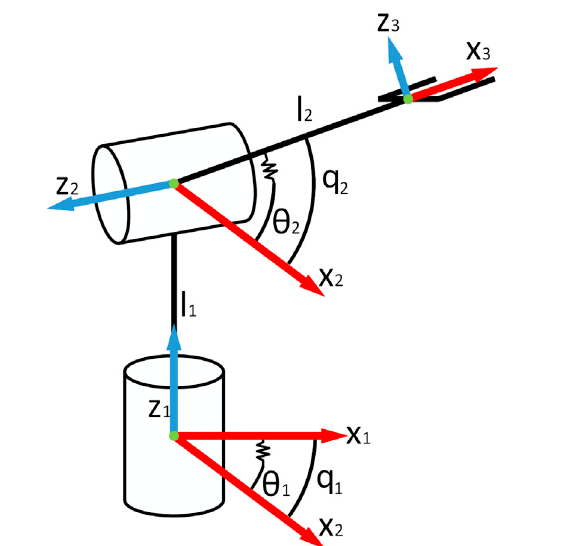
FIGURE 8 | Diagram of the elastic robot arm.